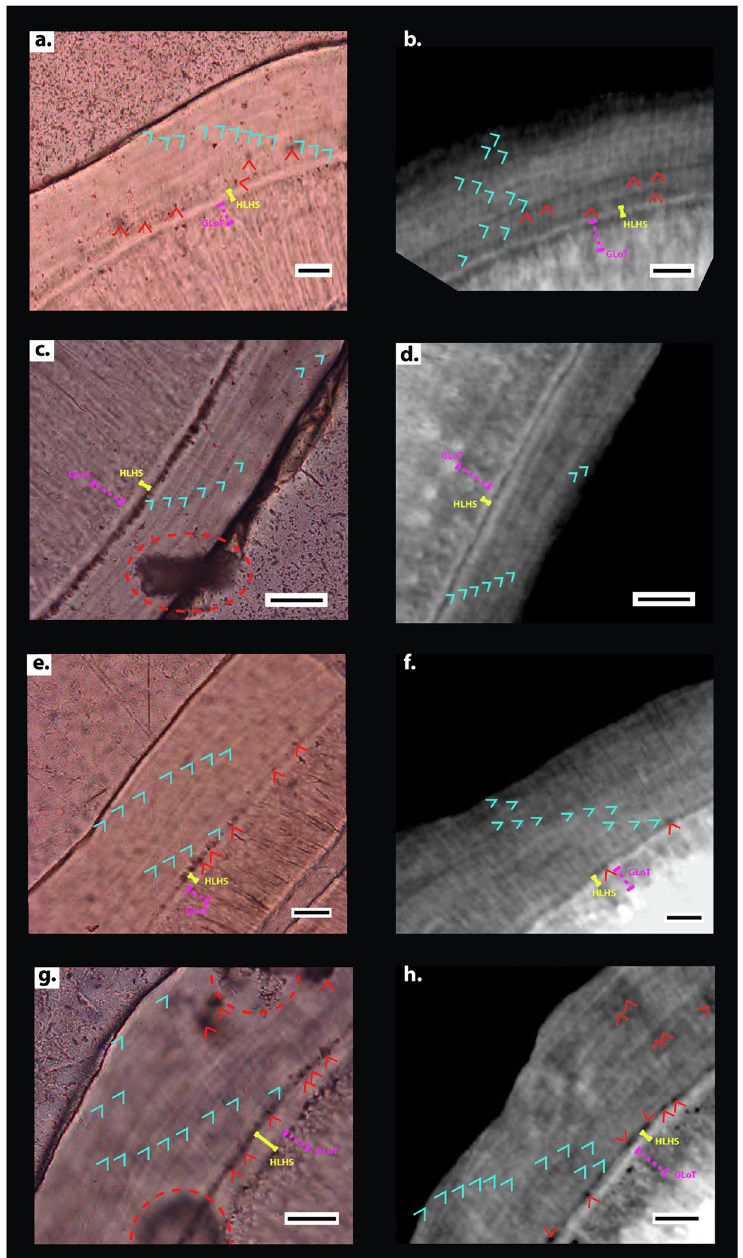
Fig 7. Comparison between histological and CT data. ( a ) Detail of histological thin-section of the k49 specimen displaying 12 light increments indicated by blue arrows. ( b ) Detail of reconstructed CT slice of the same region as ( a ) displaying 11 cementum increments. ( c ) Detail of histological thin-section of the k16 specimen displaying eight light cementum increments. ( d ) Detail of reconstructed CT slice of the same region as ( c ) displaying eight increments. ( e ) Detail of histological thin-section of the l59 specimen displaying 11 light increments. ( f ) Detail of reconstructed CT slice of the same region as ( e ) displaying 11 increments. ( g ) Detail of histological thin-section of the l56 specimen displaying 12 light increments. ( h ) Detail of reconstructed CT slice of the same region as ( g ) displaying 11 increments. See S4 Fig in S1 File for combination of histological/tomographic data for each specimen. Black scale bars represent 30 μ m. Yellow whiskers highlight the granular layer of Tomes (labelled GLoT); pink dashed whiskers highlight the hyaline layer of Hopewell Smith (labelled HLHS); and red arrows highlight cellular voids within cellular intrinsic fibre cementum. Red dashed circles highlight surface damage created during thin-section